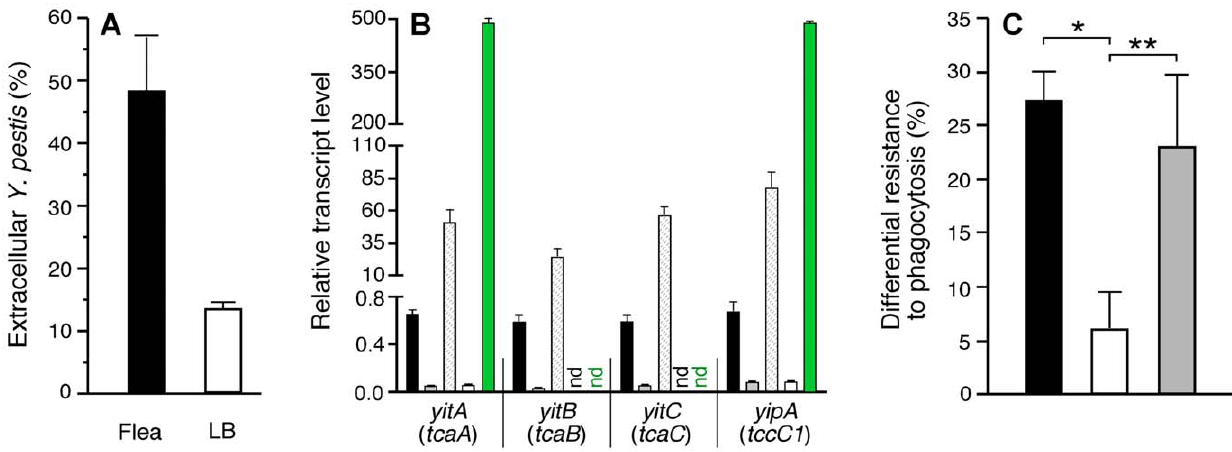
Figure 4. Phagocytosis-resistant phenotype of Y.pestis isolated from fleas correlates with expression level of the yit - yip insecticidal- like toxin genes. (A) The percentage of extracellular Y. pestis KIM6 + 1 hour after addition to murine bone marrow macrophages are shown for bacteria from in vitro cultures (LB) or from infected fleas. The mean and SEM of five independent experiments done in duplicate are shown; P , 0.0001. (B) Relative transcript levels of insecticidal-like toxin genes in Y. pestis KIM6 + wt grown in LB (black bars), D yitR mutant grown in LB (grey bars), D yitR mutant from fleas (white bars), and the complemented D yitR mutant from LB (hatched bars) and from fleas (green bars); nd=not done. The mean and SEM of three independent experiments done in triplicate are shown. Values corresponding to separate segments of the y-axis are significantly different ( P , 0.001); values for LB-grown wt bacteria (black bars) are also significantly different from values represented by the grey and white bars ( P , 0.05). (C) Differential resistance to phagocytosis by murine macrophages (% extracellular flea-derived bacteria minus % extracellular in vitro - grown bacteria) of Y. pestis KIM6 + wt (black bar, n=3), D yitR mutant (white bar, n=3), and complemented D yitR mutant (grey bar, n=2). The mean and standard error of the n experiments done in duplicate are indicated; * P , 0.01; ** P =0.06.